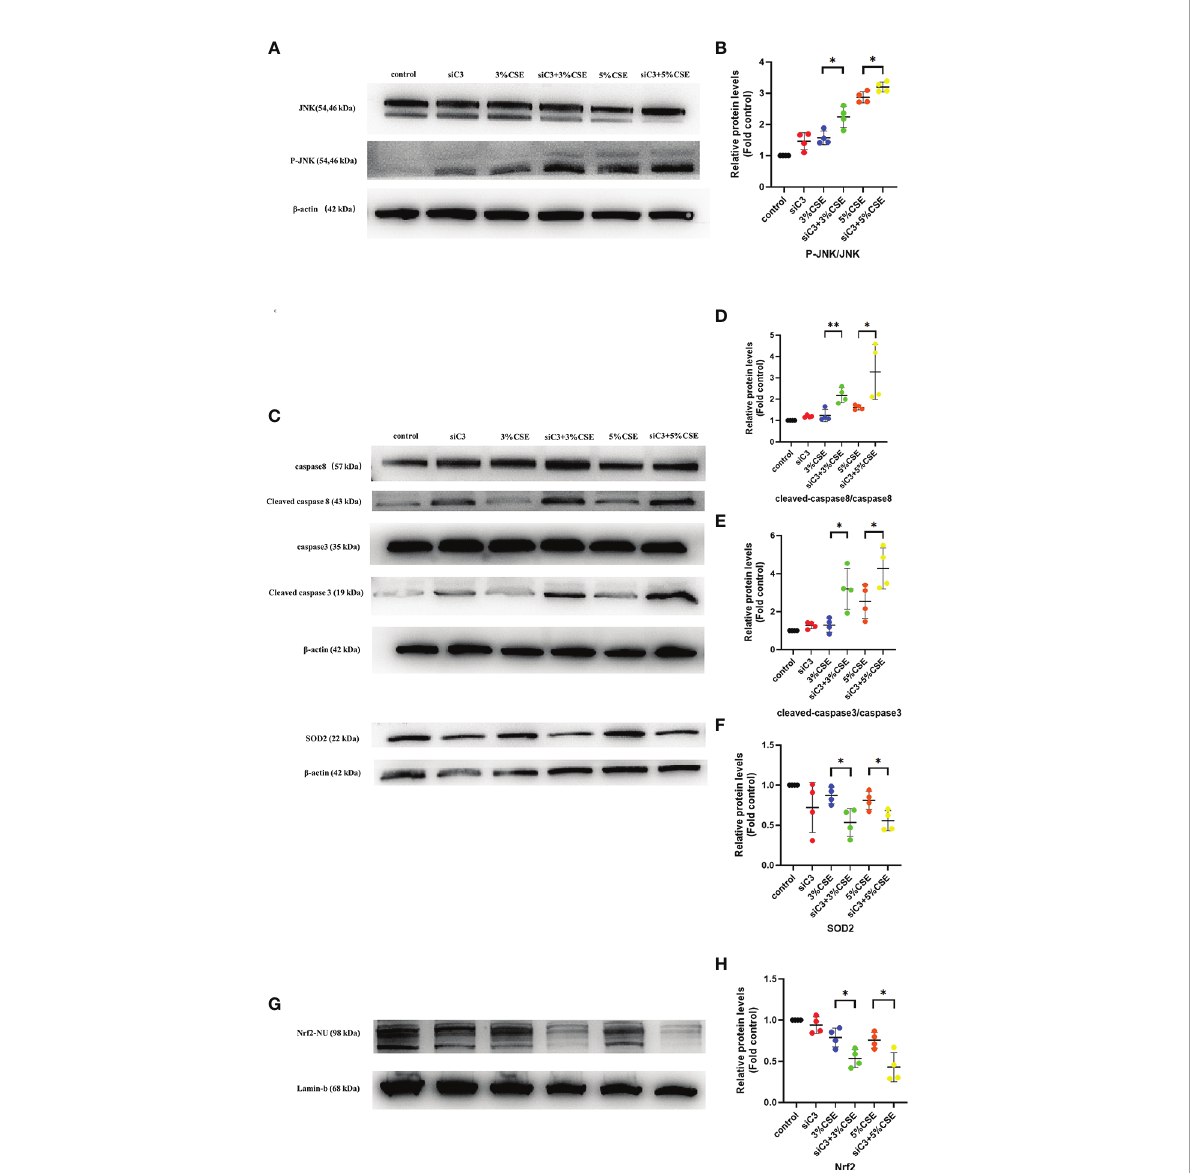
FIGURE 6 Effects of C3 knockdown on JNK pathway, oxidative stress-, and apoptosis-associated proteins induced by CSE in vitro . 16HBE cells were transfected with siControl or siRNA targeting human C3 (siC3). Cells were then left untreated (control) or treated with CSE (3% and 5%, respectively) for 24 h. P-JNK, JNK, cleaved caspase 8, caspase 8, cleaved caspase 3, caspase 3, and Nrf2 inside the nucleus and SOD2 were measured by western blot. (A, B) JNK pathway was activated in C3-silenced cells. (C-H) C3 inhibition increased the level of cleaved caspase 8 and cleaved caspase 3, and decreased the level of Nrf2 and SOD2 induced by CSE. * P < 0.05. ** P < 0.01 N = 4 independent